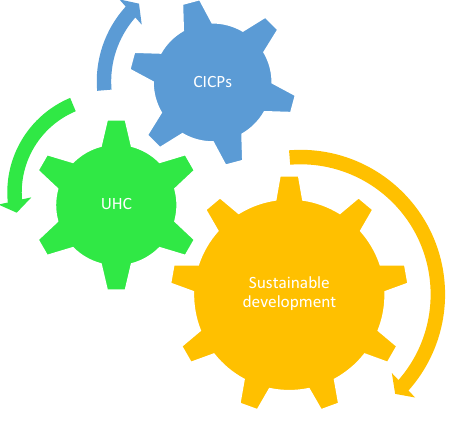
Figure 1: CICPs drive sustainable development by ensuring UHC